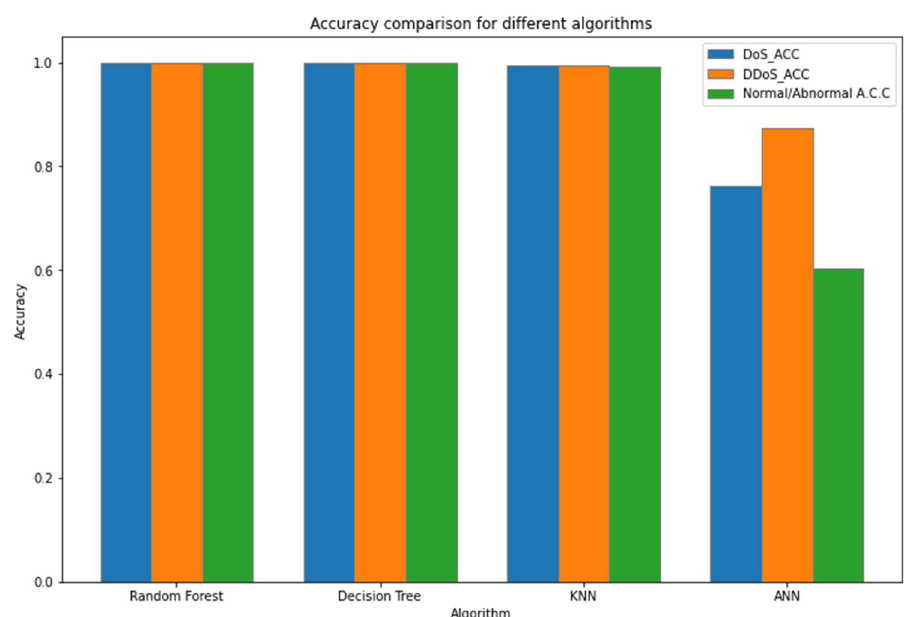
Figure 7. Accuracy comparison for different algorithms.